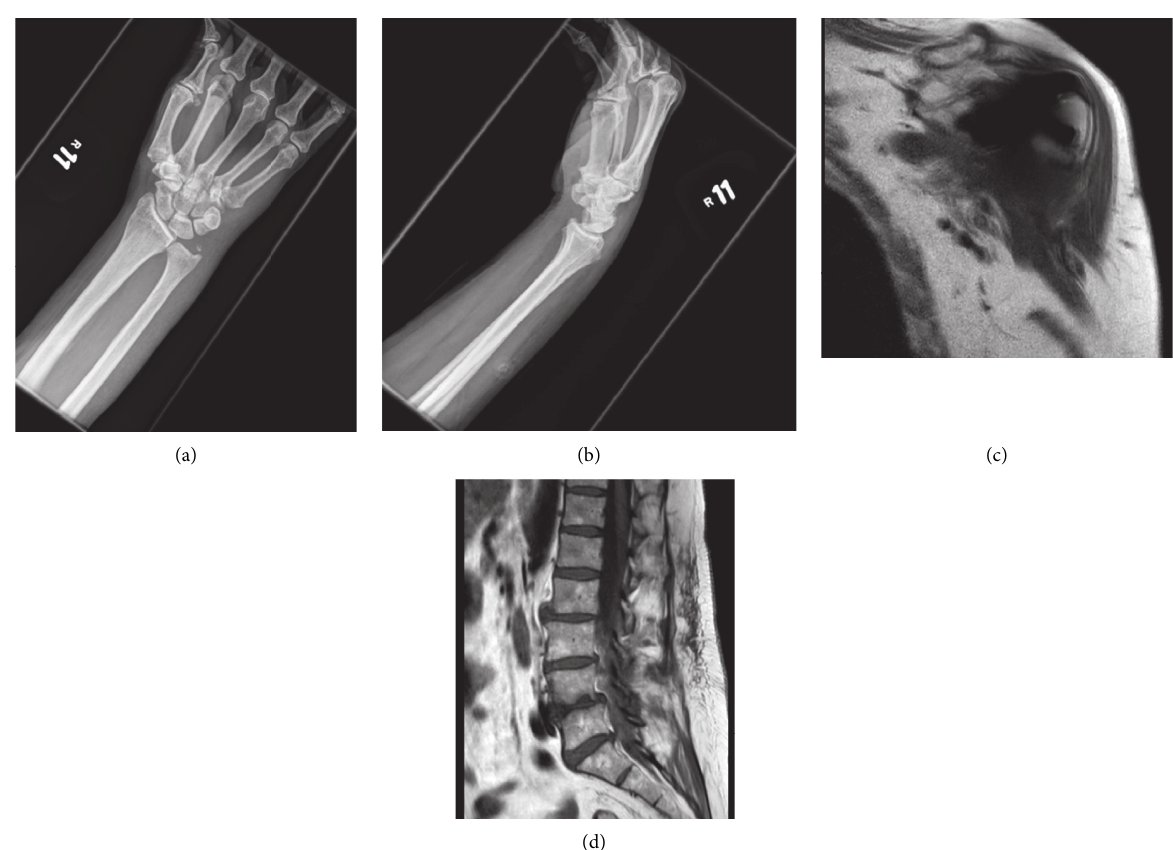
Figure 1: (a) PA X-ray right wrist, (b) lateral X-ray right wrist, (c) T1 coronal MRI right shoulder, and (d) T1 sagittal lumbar